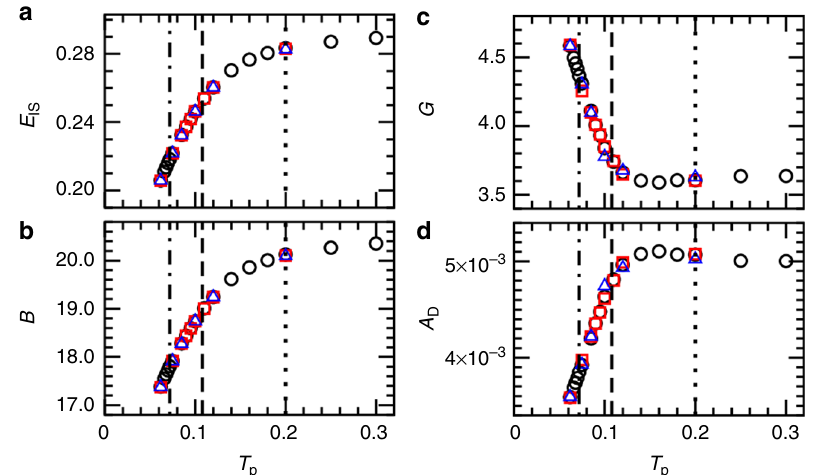
Fig. 1 Macroscopic properties. a Inherent structure energy E IS ; b Bulk modulus B ; c Shear modulus G ; d Debye level A D . In all panels, the vertical dashed- dotted, dashed, and dotted lines mark the positions of T g , T c , and T o , respectively. Data shown are for N = 48,000 (circles), 96,000 (squares), and 192,000 (triangles)